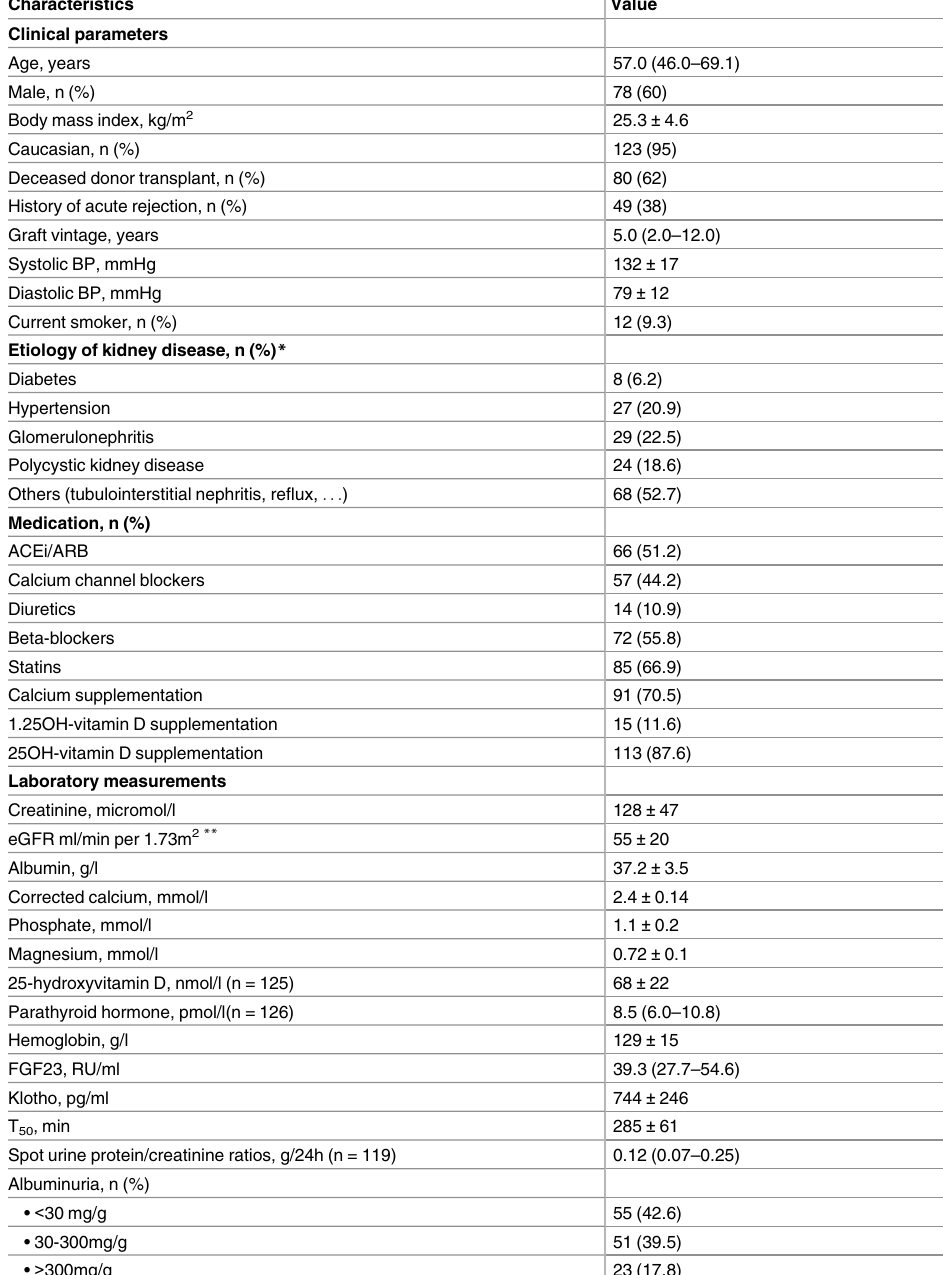
Table 1. Baseline characteristics of the study population (n = 129): clinical parameters, medication and laboratory